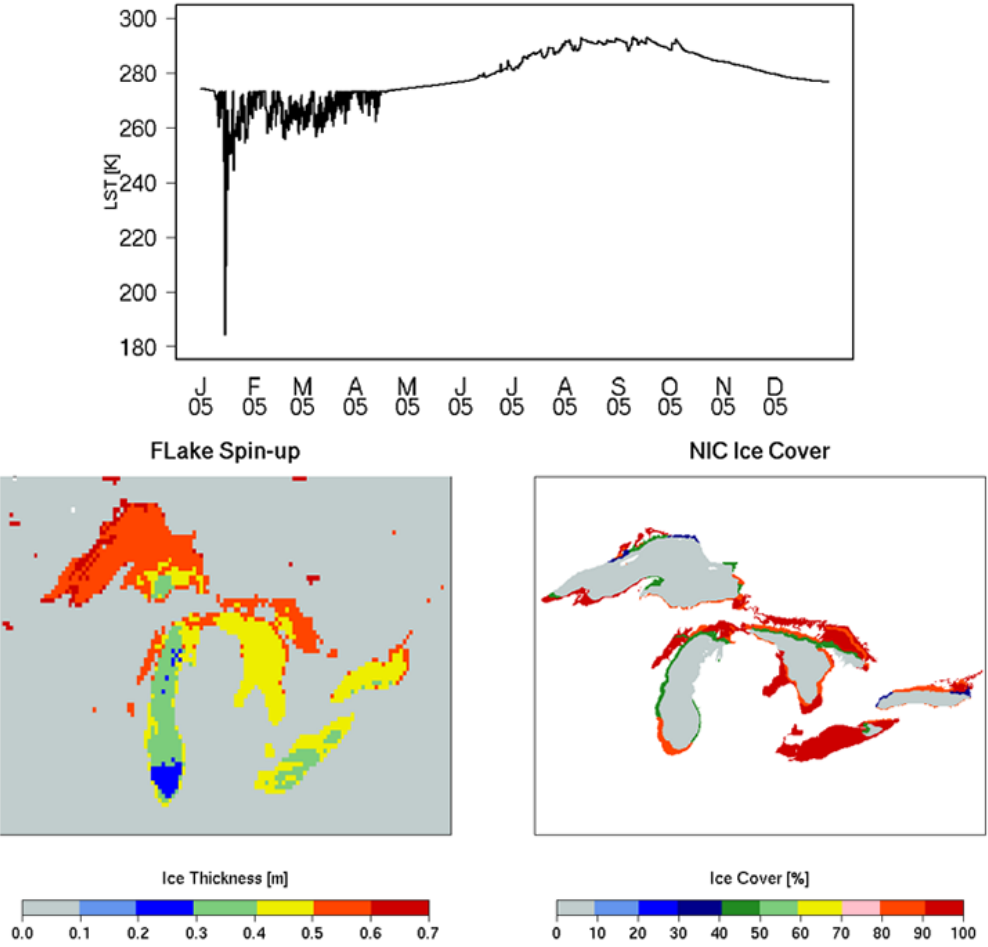
Figure 3. Surface temperature from the initial year of a 10-year FLake spin-up simulation, taken from a point near the north shore of Lake Superior (48.47 ◦ N, 87.54 ◦ W) and shown hourly from 1 January to 31 December 2005 (top). LSTs at all lake cells are initialized with a default value of 274.15K, and the time series shows either ice or water surface temperatures depending on whether ice is present. Simulated ice thickness (m) taken from day 30 of the same FLake simulation, valid 30 January 2005 (bottom left). Fractional ice values observed on this date plotted from the NIC ice analysis (bottom